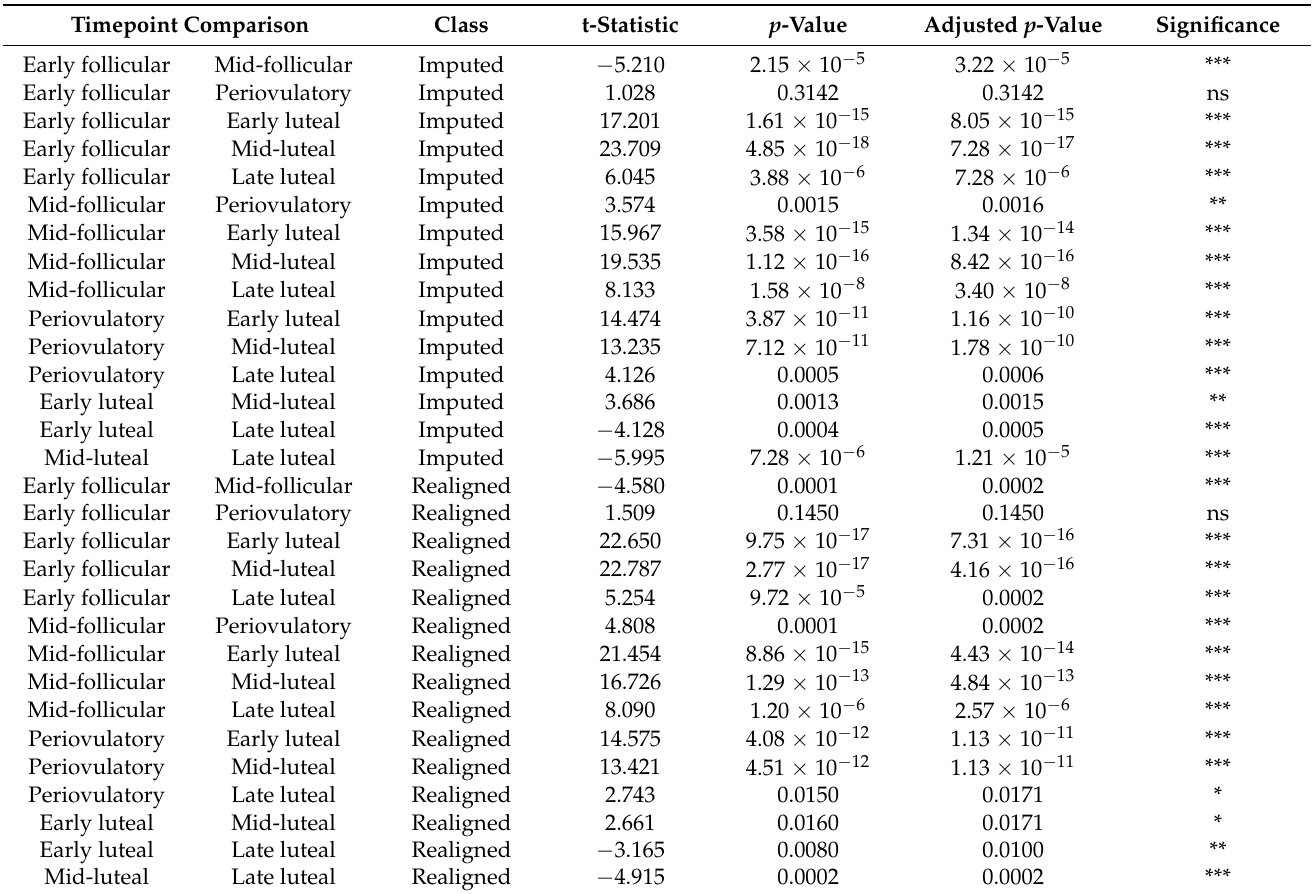
Table 2. Allopregnanolone subphase